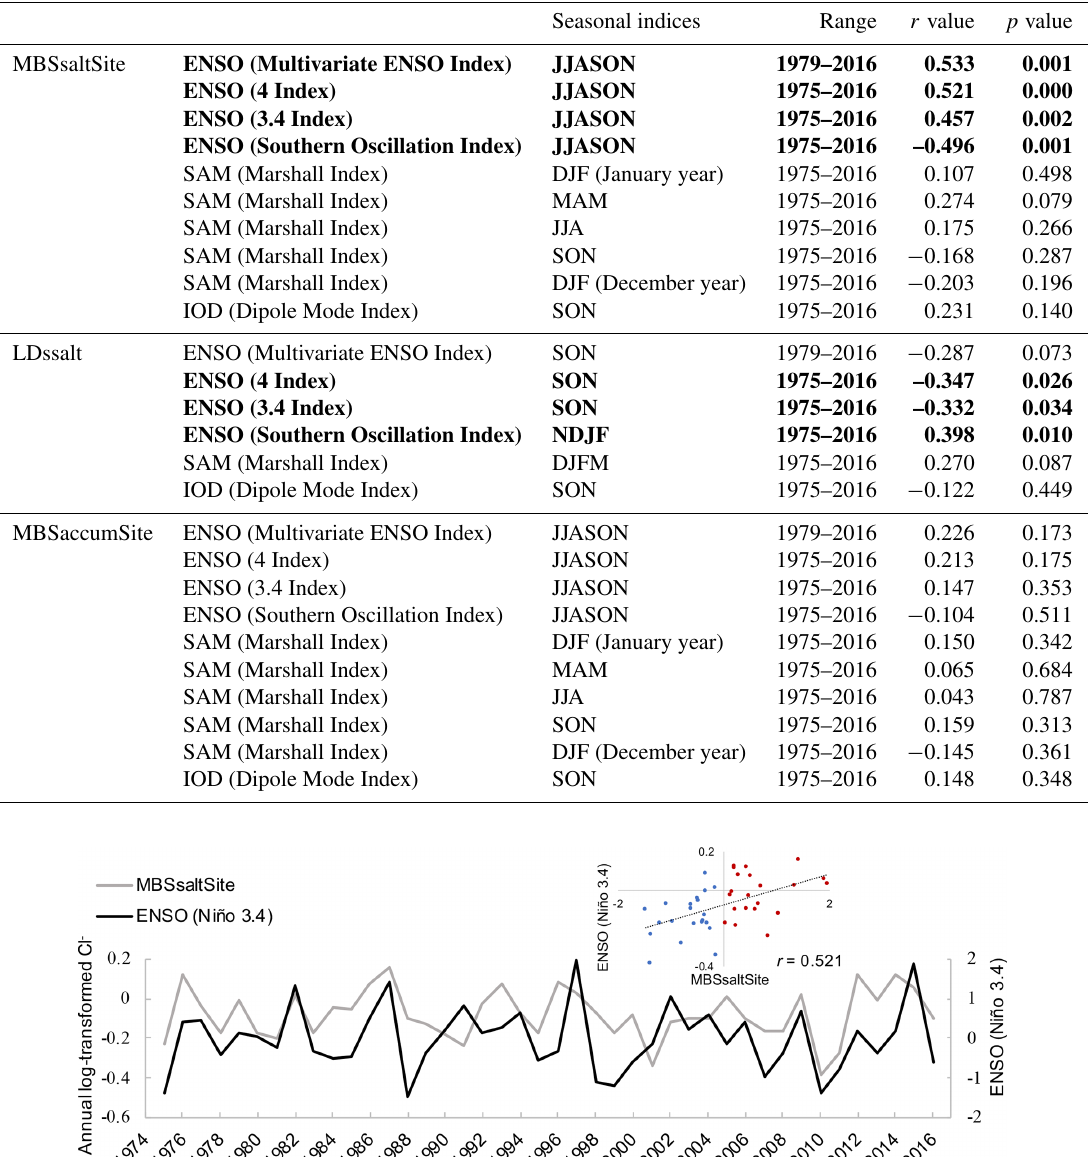
Table 1. Pearson’s correlation coefficient for the detrended accumulation (MBSaccumSite) and detrended annual log-transformed sea salt concentrations for the Mount Brown South site average (MBSsaltSite) and the detrended summer log-transformed sea salt concentration (LDssalt) for the Law Dome (Dome Summit South site) record against detrended seasonal ENSO, SAM, and IOD indices. Correlations significant at 95% are bold, and the dates range between 1975–2016.